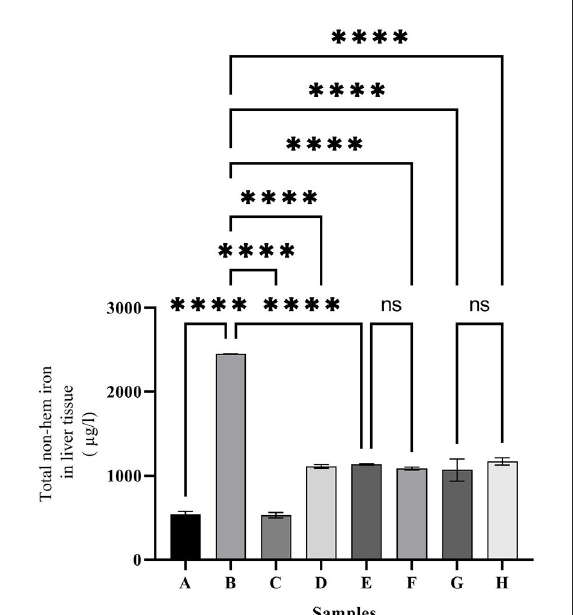
FIGURE3 Liver non-hem iron content in the treated mice. Group A: control group, normal saline-receiving group; Group B: normal saline and DFO-receiving group; Group C: iron dextran and normal saline-receiving group; Group D: iron dextran and DFO-receiving group; Group E: low dose caffeic acid-receiving group (30 mg/kg/day); Group F: high dose caffeic acid-receiving group (50 mg/kg/day); Group G: low dose ferulic acid-receiving group (30 mg/kg/day); and Group H: high dose ferulic acid-receiving group (50 mg/kg/day) (Mean ± SD; ns, non-significant and **** p ≤